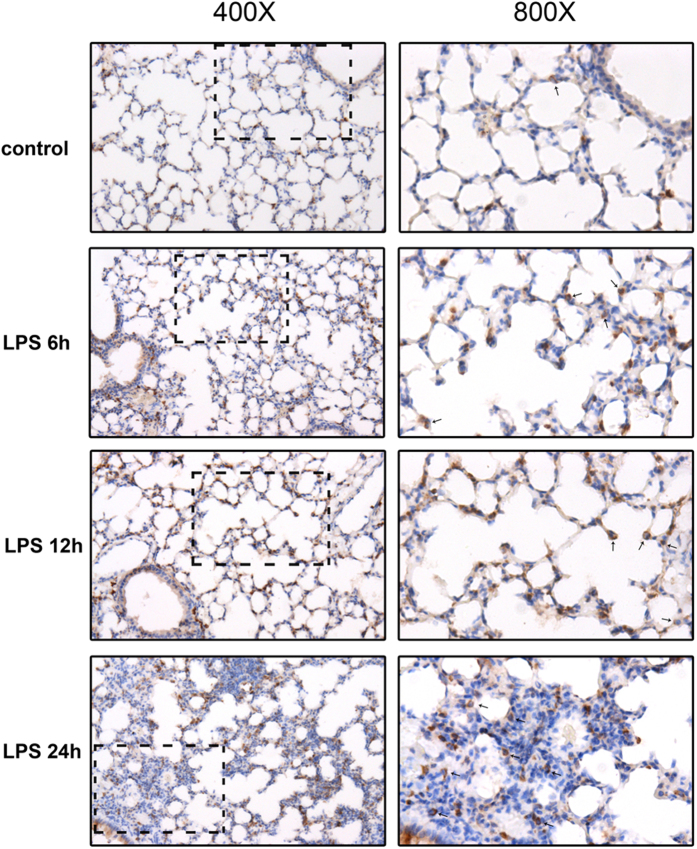
Immunohistochemistry of CD74 staining in lungs.Immunohistochemical examination was performed for CD74 in control mouse lung tissue and lipopolysaccharide induced acute lung injury model (6 h, 12 h, 24 h post lipopolysaccharide instillation). CD74 is indicated by brown staining and nuclei are counterstained in blue. Limited CD74 staining was observed in control mouse lung tissue. Increased CD74 expression in lung tissue of acute lung injury was observed. Some CD74 staining was localized on cell membrane of nucleated cells (arrow). Left magnification ×400, Right magnification ×800.